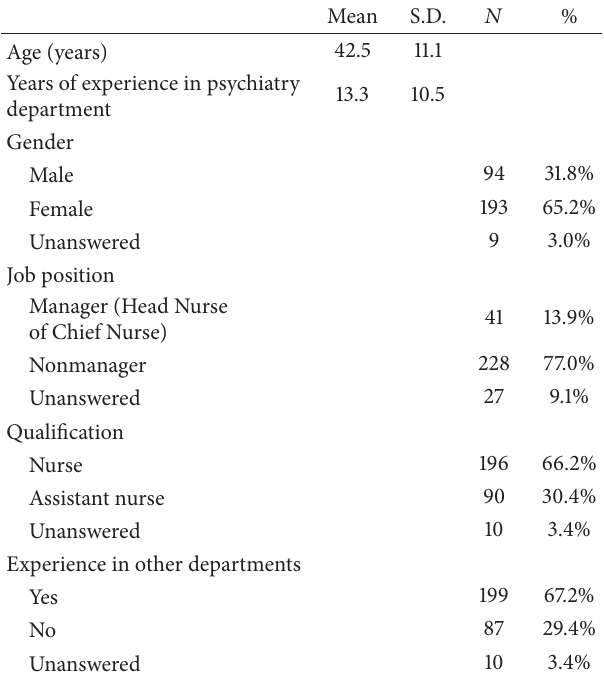
Table 2: Characteristics of subjects ( 𝑁 = 296